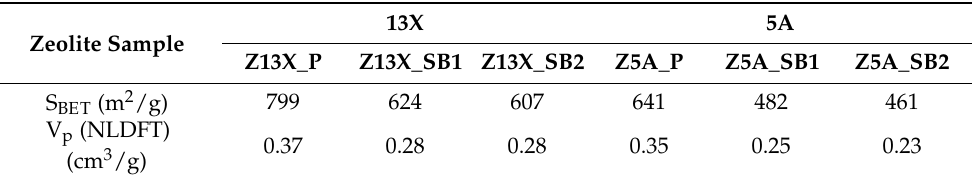
Figure 3. Pore size distribution of different zeolite samples. ( a ) 13X zeolites, and ( b ) 5A zeolites obtained with a NLDFT model (Quantachrome’s ASiQwin Software). Table 2. BET surface area and micropore volumes of different zeolite samples.